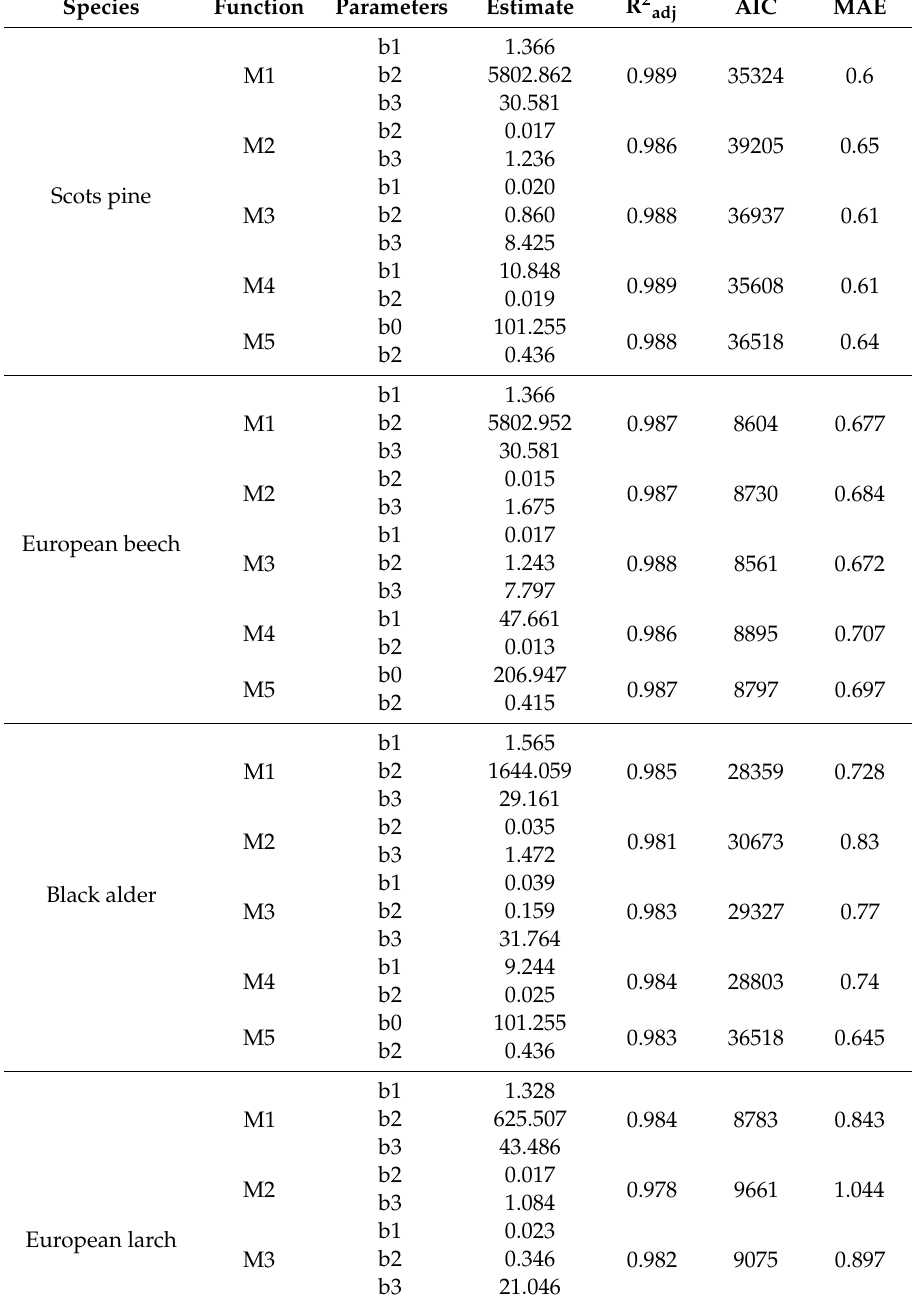
Table 3. Parameter estimates and goodness-of-fit statistics for the individual site functions and species. R 2 : Coe ffi cient of determination. AIC: Akaike information criterion. MAE: Mean absolute